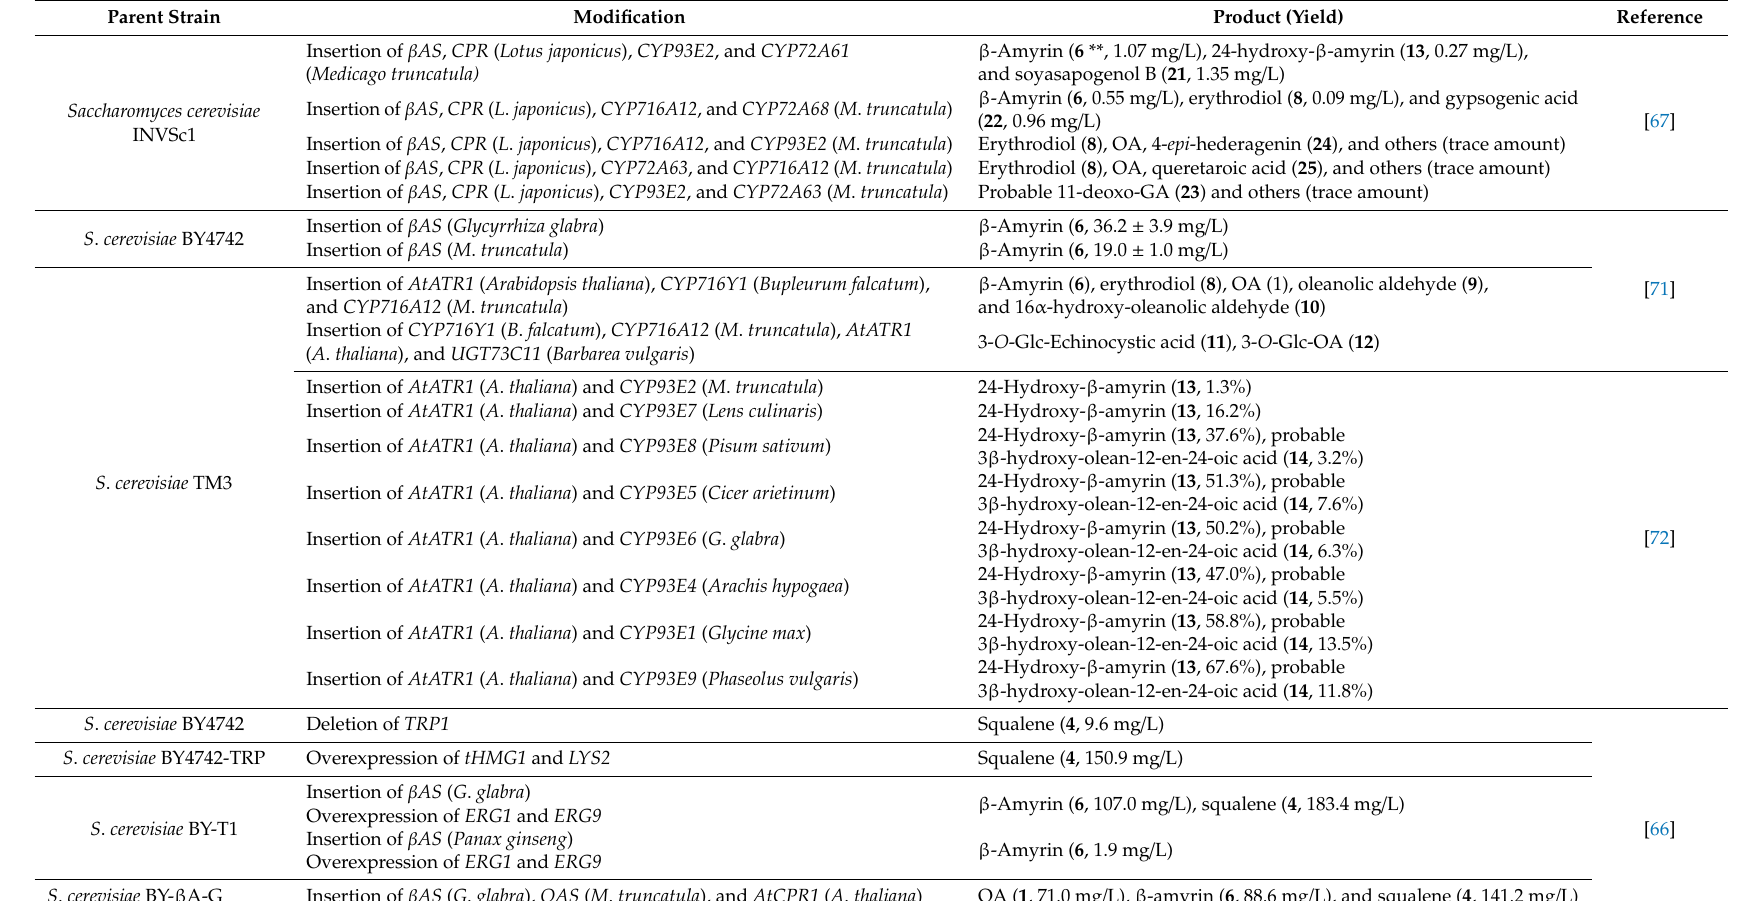
Table 2. Biosynthesis of pentacyclic triterpenoids using engineered